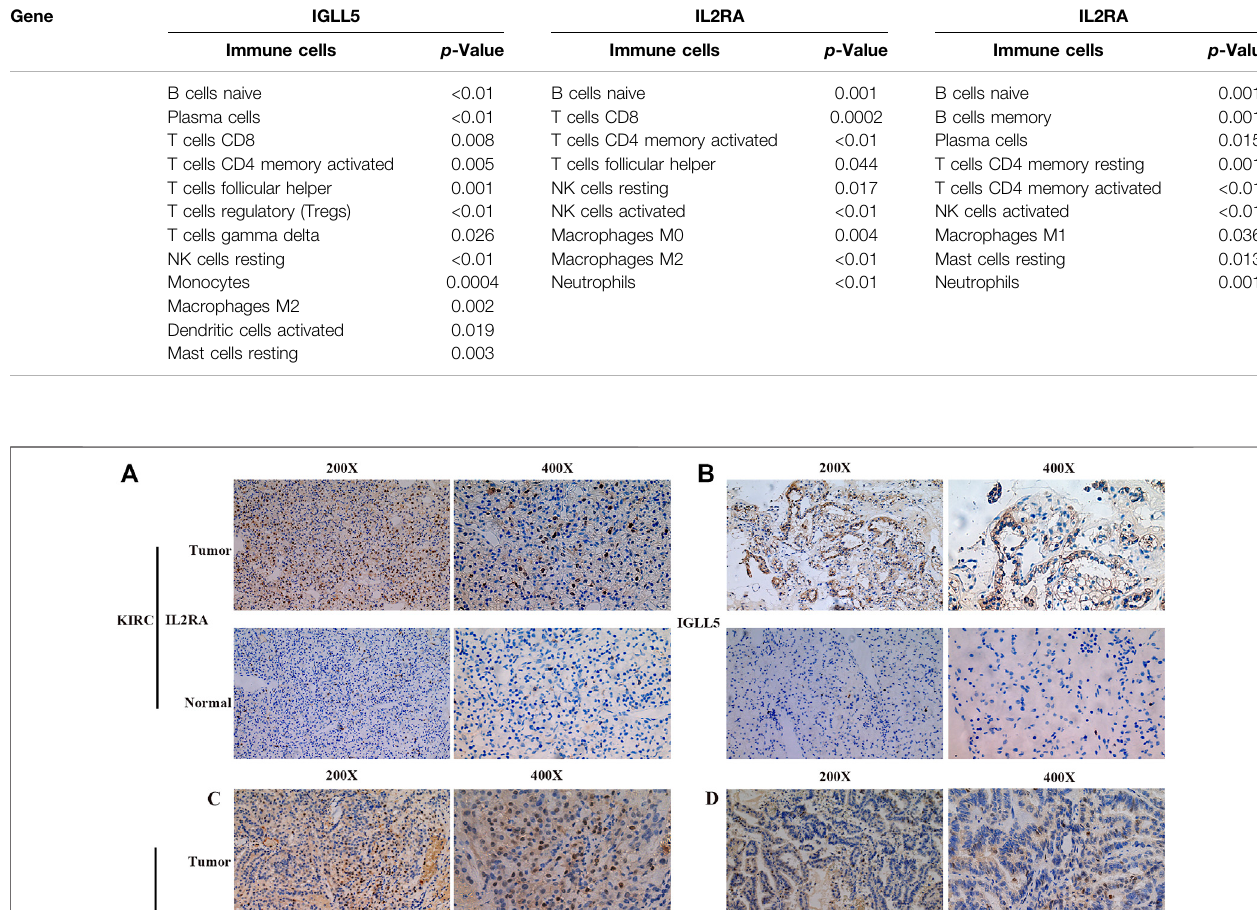
TABLE 1 | The intersected immune cells related to IGLL5 and IL2RA in ccRCC and pRCC. Cancer types